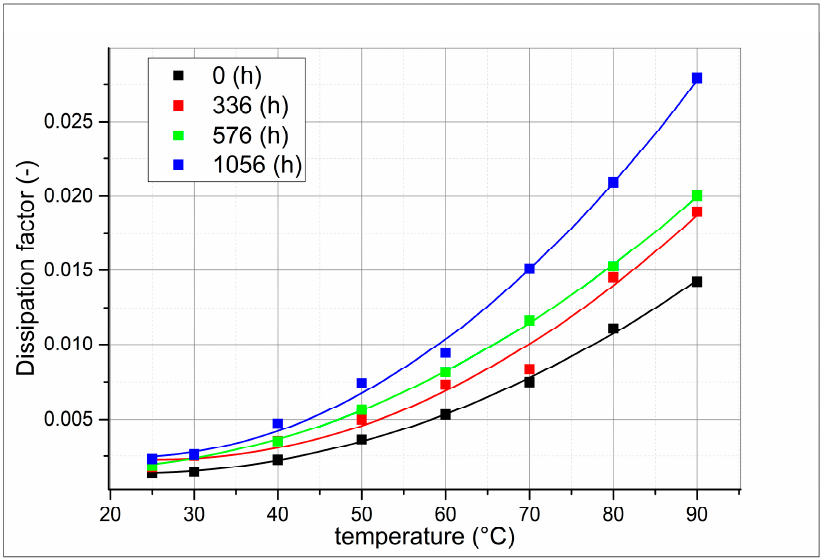
Figure 4. Thermal dependency of the dissipation factor of sunflower oil at 140 °C exposure for different exposure times.